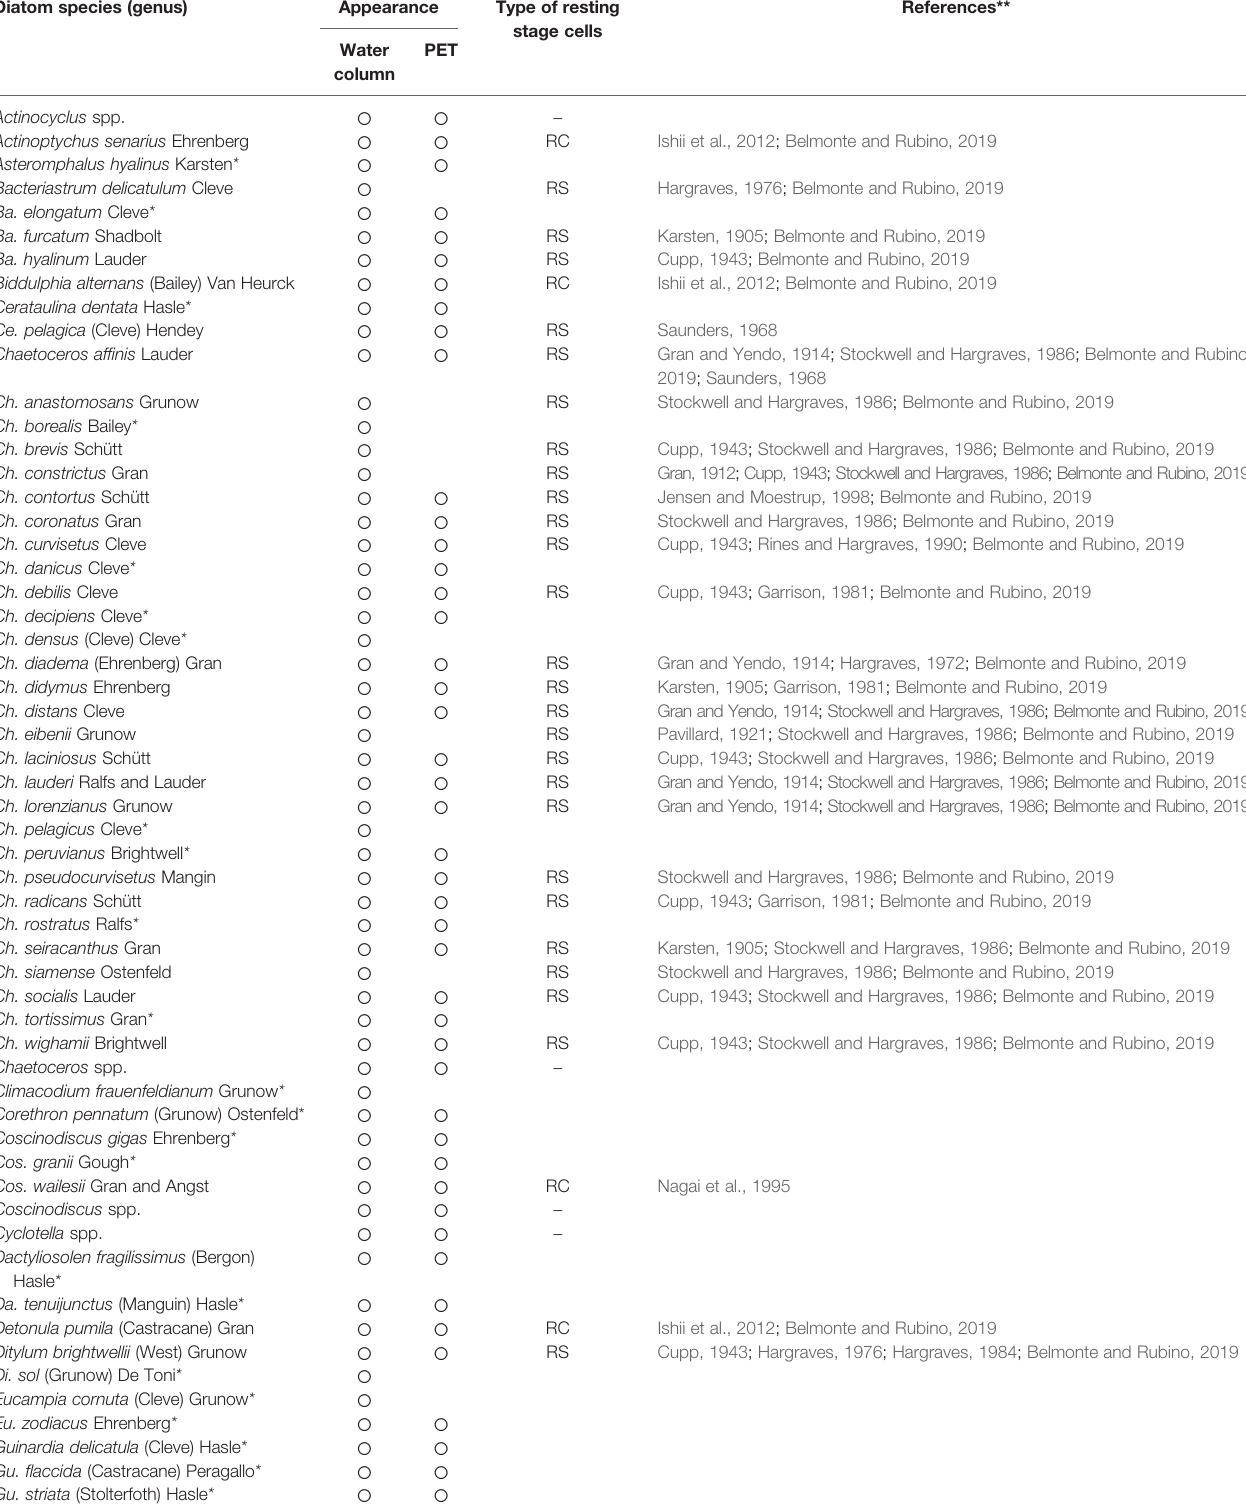
TABLE 1 | Compiled list of species (genus) of centric diatoms observed in the water column and PET chamber at the sampling site in Ago Bay, during the period from July 2006 to May 2008. Diatom species (genus)